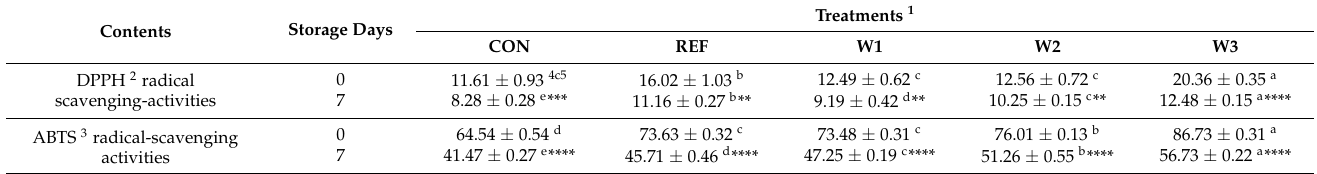
Table 10. Anti-oxidative properties of Tteokgalbi prepared with watermelon radish powder during storage.